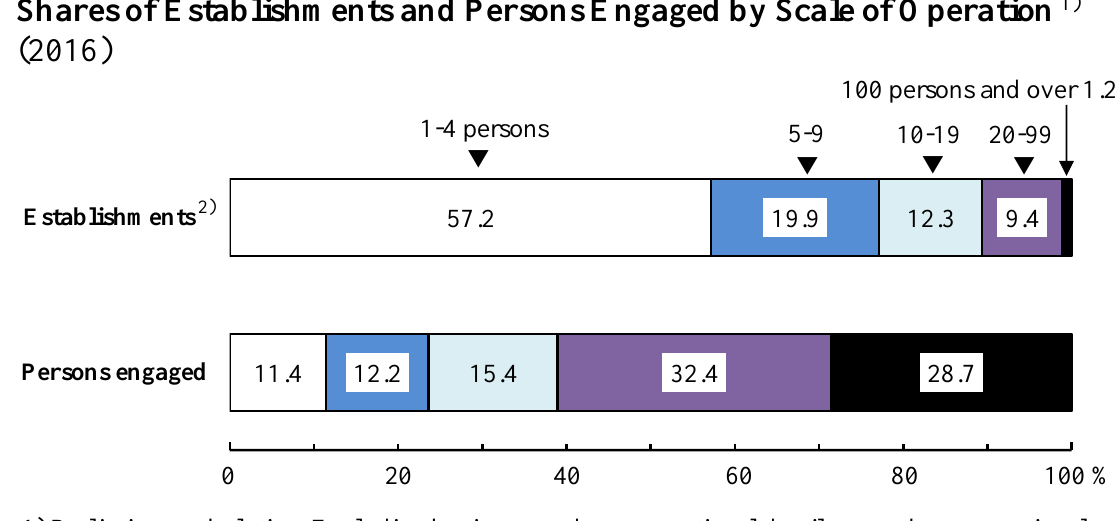
Shares of Establishments and Persons Engaged by Scale of Operation